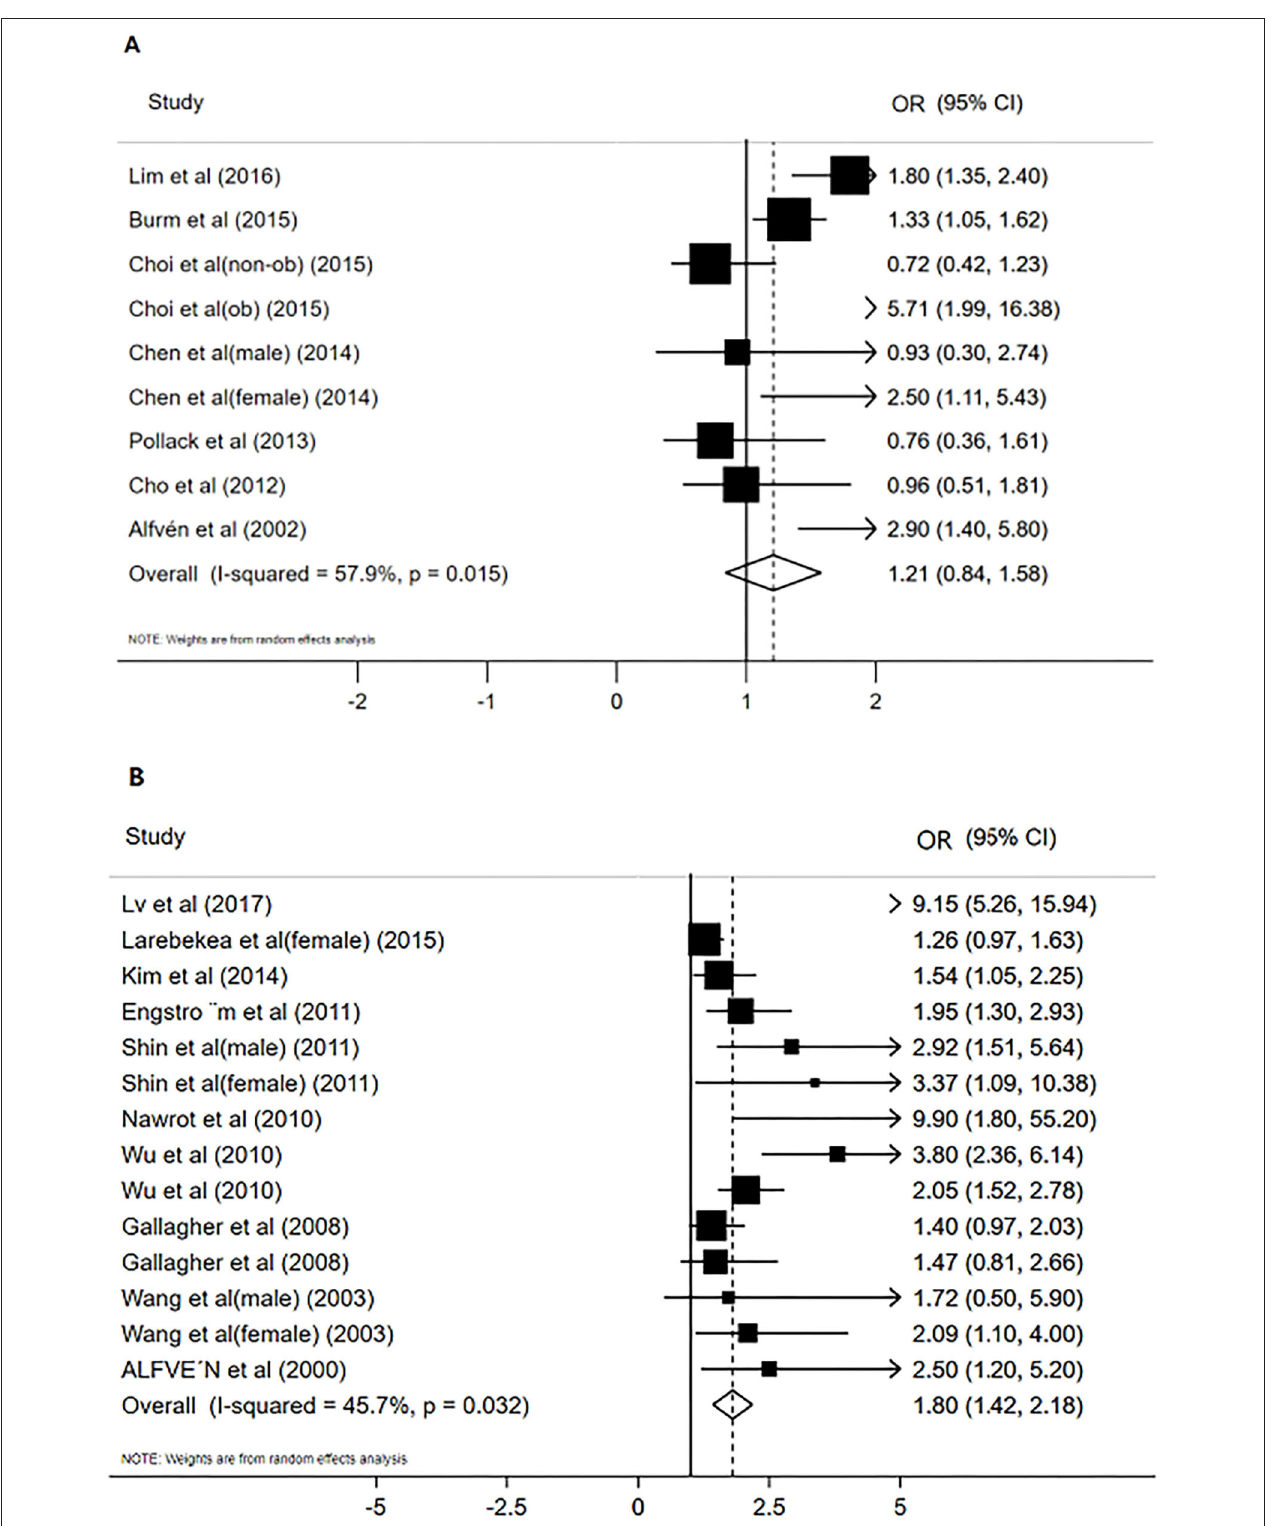
FIGURE 2 | The forest plot for studies on the concentration of blood Cd and osteoporosis or osteopenia (A) , Urinary Cd concentration and osteoporosis or osteopenia (B) .